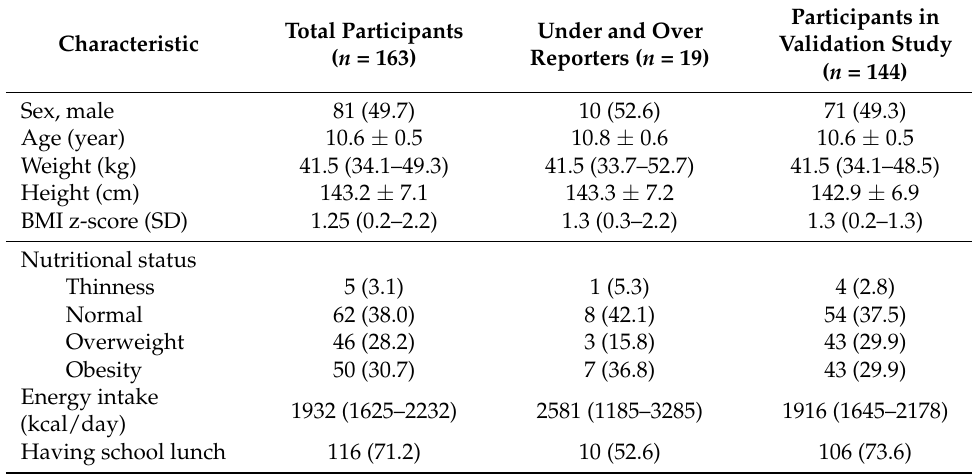
Table 2. Characteristics of participants in the validation of VCSDQ